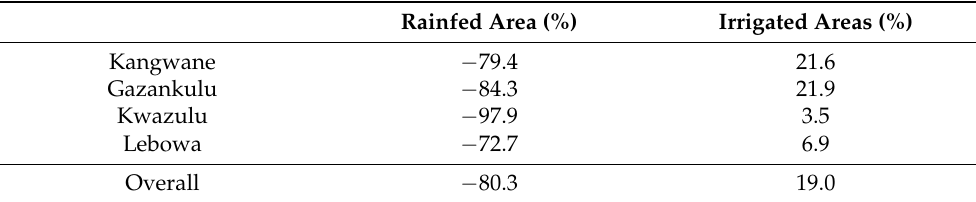
Table 5. Percentage change in agricultural systems in former homelands between 2019 and 2020.